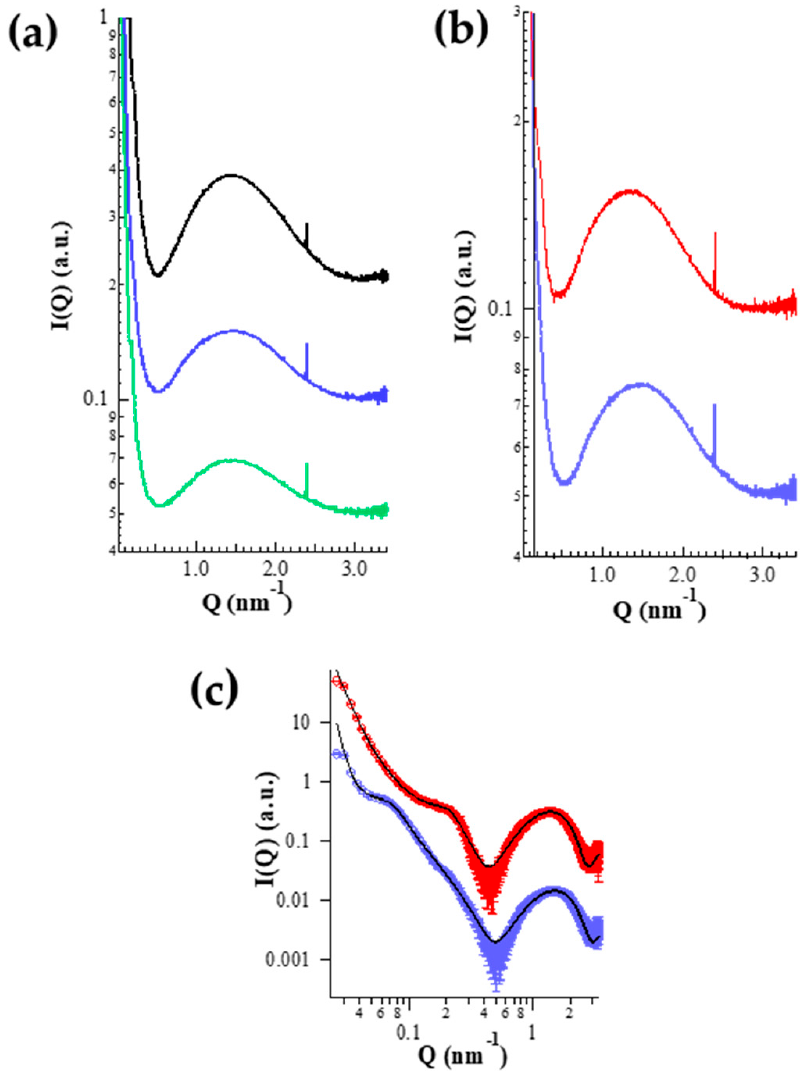
Figure 3. Small angle X-ray scattering (SAXS) profiles observed for the di ff erent ETHO samples at 25 ◦ C. ( a ) ETHO 0.6 (green), ETHO 0.9 (blue), ETHO 1.5 (black). ( b ) ETHO-CoQ10 (red), ETHO 0.9 (blue). ( c ) Fitting analysis of the ETHO-CoQ10 (red) and ETHO 0.9 (blue) curves by the new GENFIT model [50]. The continuous black lines are the best fit curves; the fitted Q-range corresponds to the length of the traced lines. In each frame, curves are scaled for clarity.